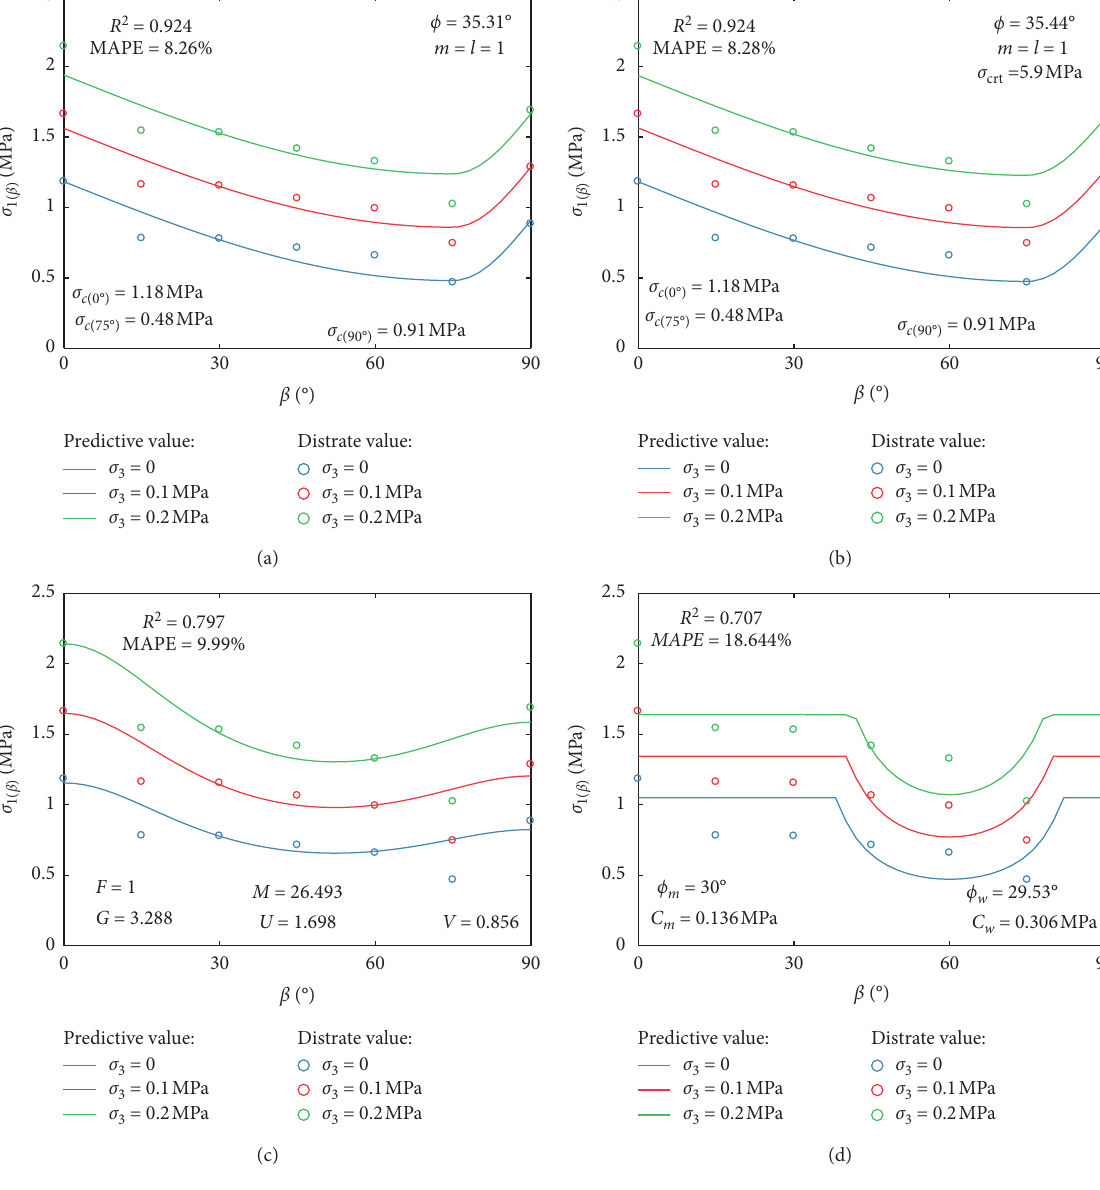
Figure 11: Predicted strength of the layered rock mass and the material coefficients of the four criteria. (a) LEE. (b) NLEE. (c) Pariseau ( n � 1). (d)